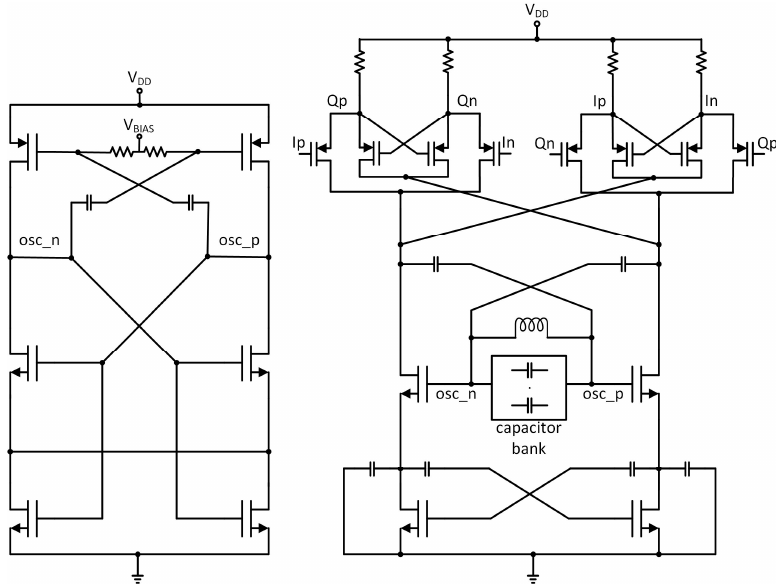
Figure 19. Simplified schematic diagram of the designed digitally controlled oscillator (DCO). Two ADPLLs for the L1 / E1 and L5 / E5 bands were implemented in the GNSS SoC. The phase noise of each frequency synthesizer equals − 121 dBc / Hz at 1 MHz from the carrier frequency, while 4.5 mA is consumed from a 1.5 V supply. The post-layout DCO simulation tuning characteristics and phase noise are presented in Figures 20–23.